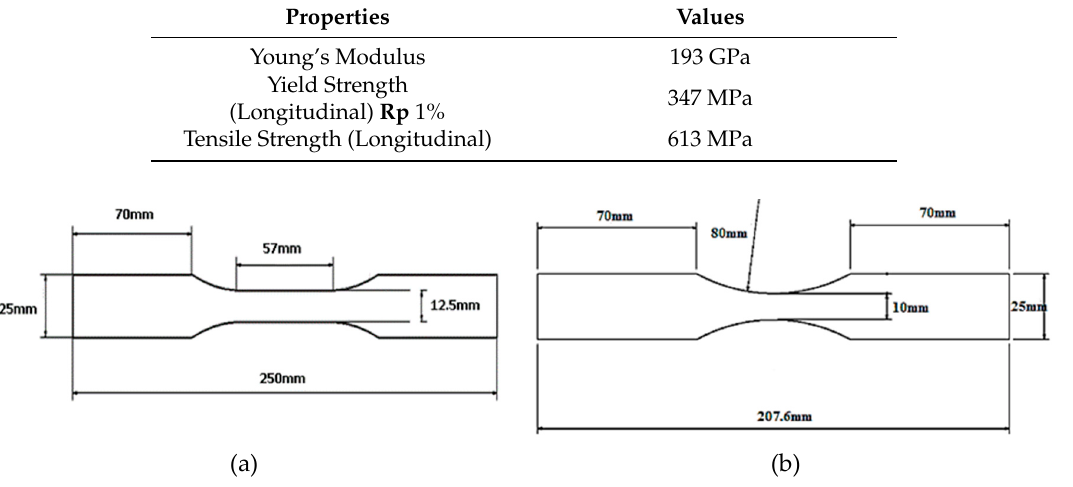
Figure 8. Dimension of the specimen: (a) tensile and (b) fatigue.